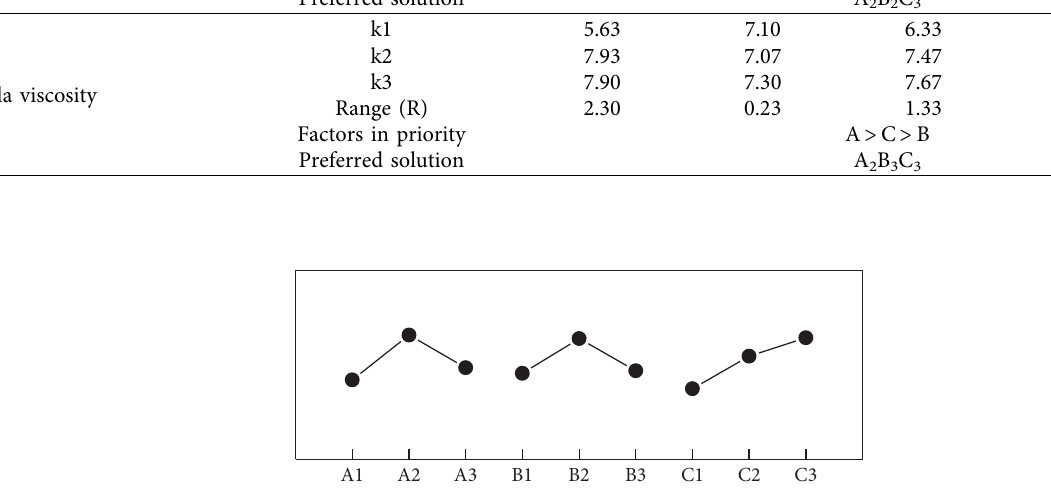
Figure 5: Trend fgure of the comprehensive index.